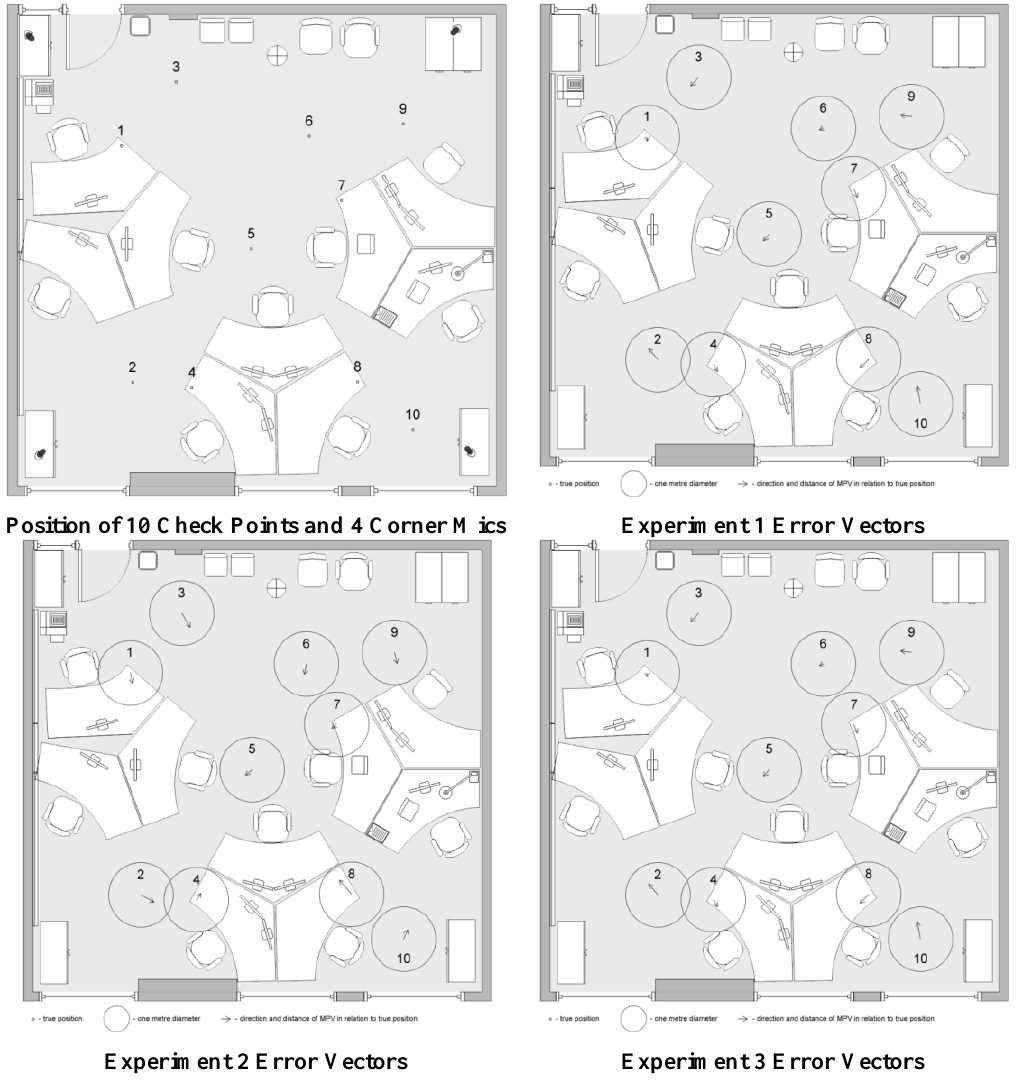
Figure 3. The position of 10 test locations or check points (centerpoint of 1 m diameter circles) and error vector direction and distance from true position to MPV for Experiments 1, 2, and